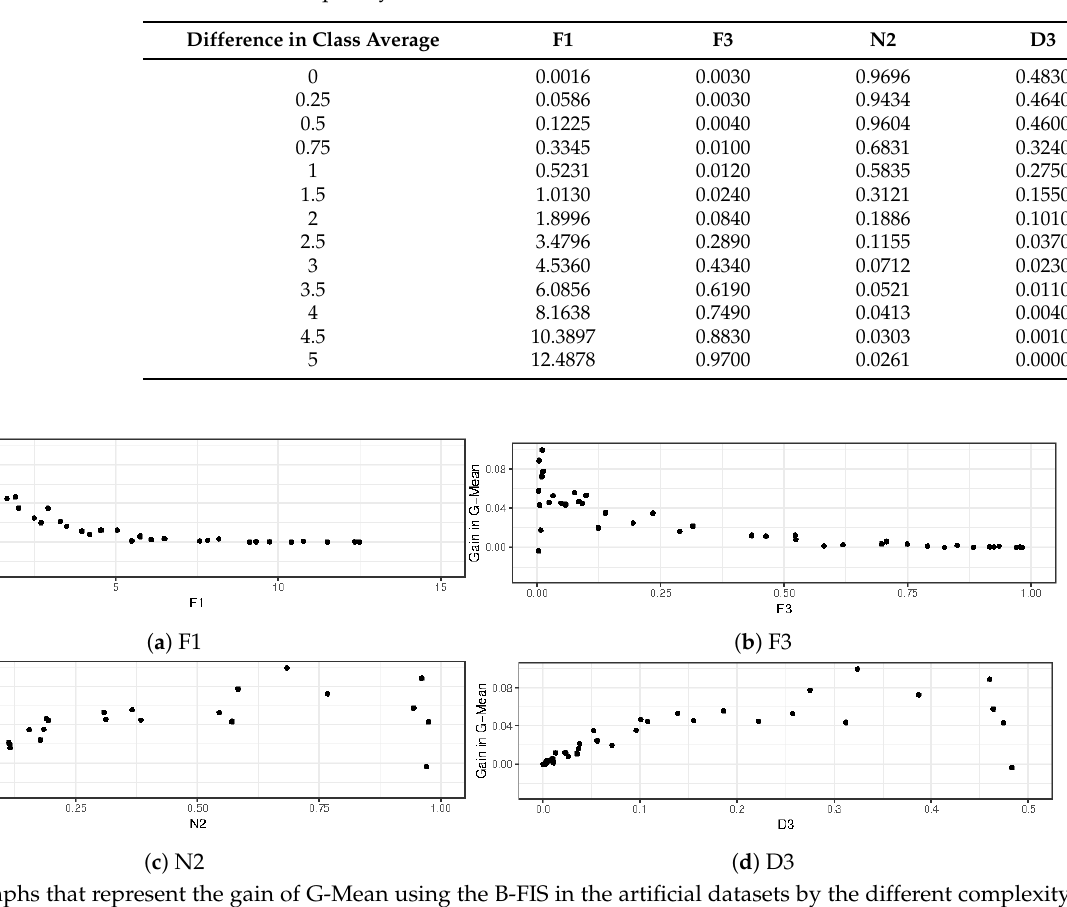
Table 8. Data complexity measures for the artificial datasets.